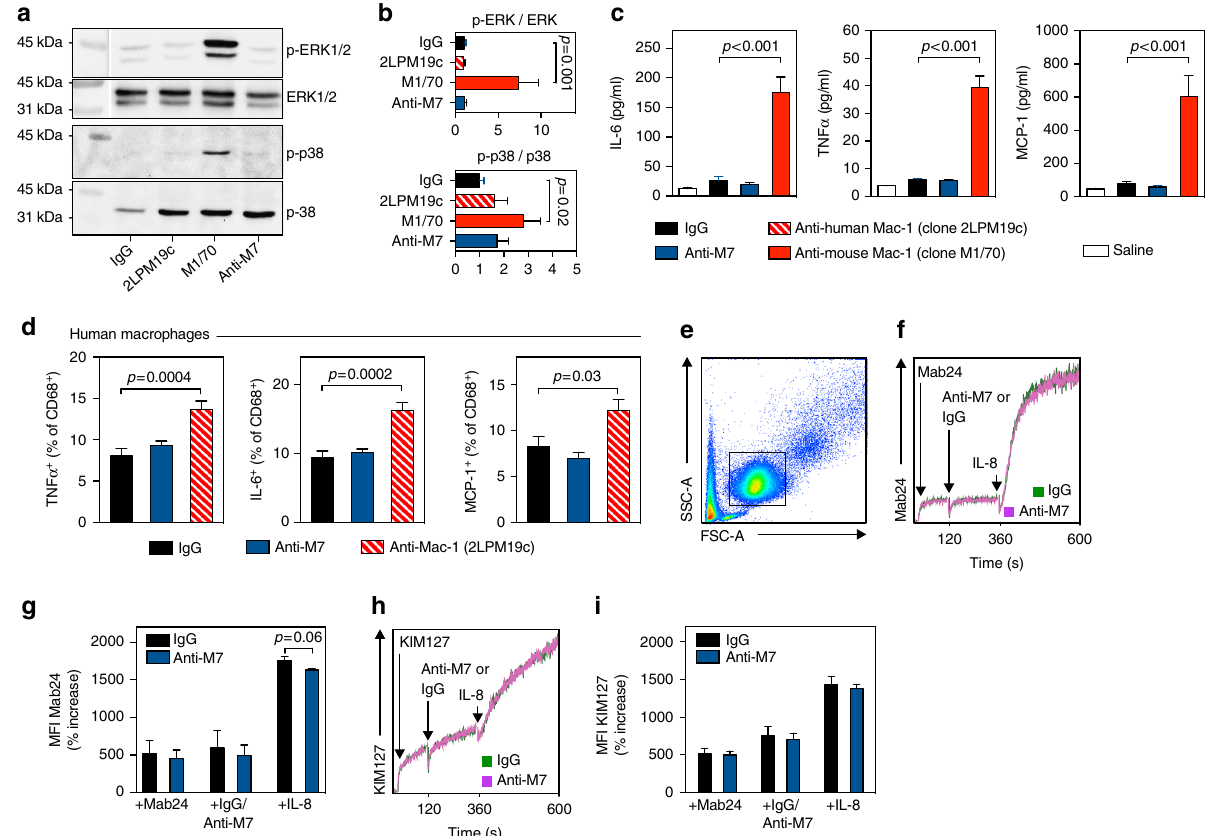
Fig. 3 Conventional anti-Mac-1 therapy, but not a ligand-speci fi c inhibition by anti-M7, is a potent inducer of integrin outside-in signaling and aberrant cytokine secretion. a , b Mouse macrophages were isolated from the peritoneal cavity of C57Bl/6 mice 72 h after injection of 4% thioglycollate. Peritoneal cells were collected by lavage and the purity was con fi rmed by fl ow cytometry ( > 90% F4/80 + macrophages). Cells were cultured in 5%FCS/RPMI overnight and co-incubated with 10 μ g/ml of mouse IgG, anti-human Mac-1 (clone 2LPM19c), anti-mouse Mac-1 (clone M1/70), or anti-M7 for 30 min in the presence of an anti-mouse CD16/CD32 F c -block. Cells were lysed and total and phosphorylated ERK1/2 and p38 were visualized by western blot and the ratio of phosphorylated fractions was calculated. Values were calculated as relative arbitrary units (AU) normalized to signal of cells stimulated with saline alone. c Saline, or IgG, anti-M7, anti-Mac-1 (clone M1/70) antibodies were injected i.p. in mice and plasma concentrations of IL-6, TNF α , and MCP-1 were measured by cytometric bead array 4 h after injection. d Human macrophages were differentiated from peripheral monocytes and co-incubated with the indicated antibody clones including the anti-human Mac-1 clone 2LPM19c in the presence of an anti-human CD16/CD32 Fc-block for 5 h. Cytokines were quanti fi ed by intracellular fl ow cytometry in CD68 + macrophages. e Human neutrophils were enriched by density centrifugation of peripheral blood. f – i The anti- β 2 antibodies Mab24 (detecting the β 2 high-af fi nity conformation) and KIM127 (for β 2-extension) and anti-M7 or IgG (10 μ g/ml) were added during acquisition in fl ow cytometry. The mean fl uorescence intensity (MFI) for Mab24 ( f , g ) and KIM127 ( h , i ) was continuously recorded over 10 min within the neutrophil gate ( e ) and quanti fi ed as % of the starting MFI ( g , i ). Error bars indicate mean ± SEM. Statistical signi fi cance was assessed by a two- sided, unpaired Student ’ s T-test between the indicated groups. Data are the result of N ≥ 3 independent experiments ( a , b ). N ≥ 9 mice per group ( c ) N ≥ 6 human donors ( d ). N = 3 human donors ( f – i ). A representative FACS plot is shown in